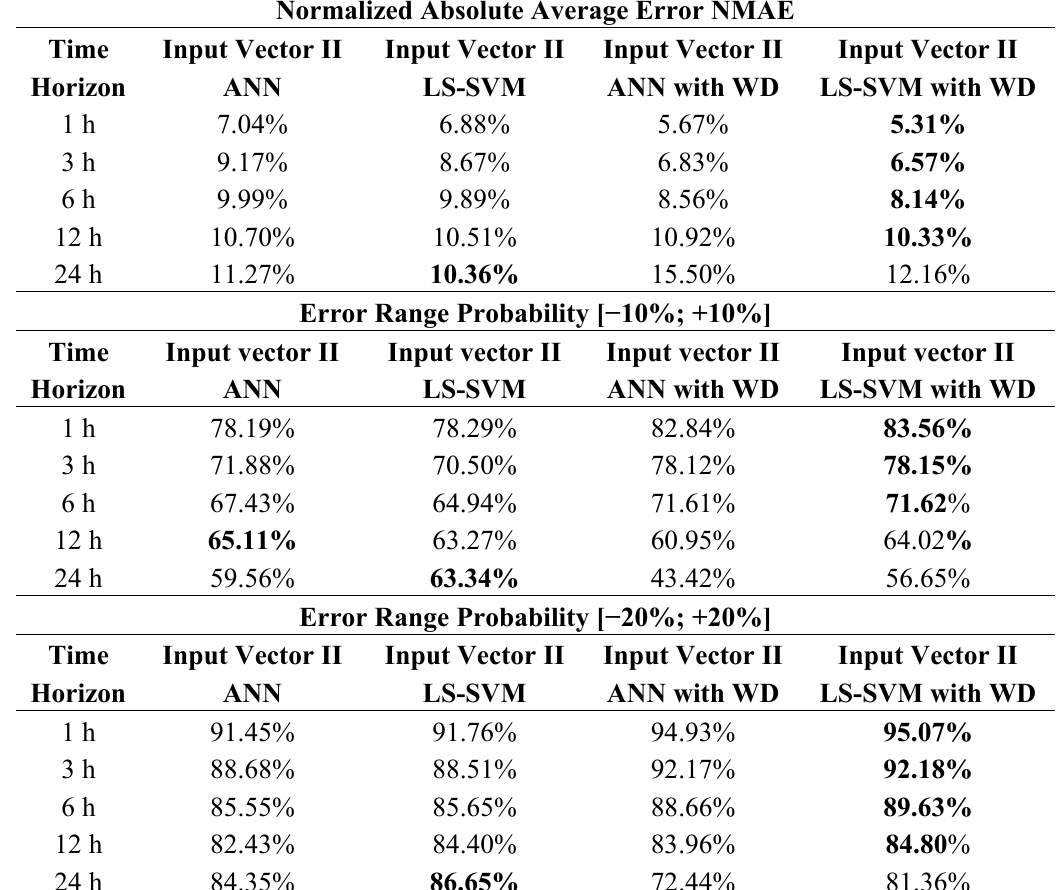
Table 5. NMAE and Error Range Probability for input vector Type II by LS-SVM and ANN without and with WD.